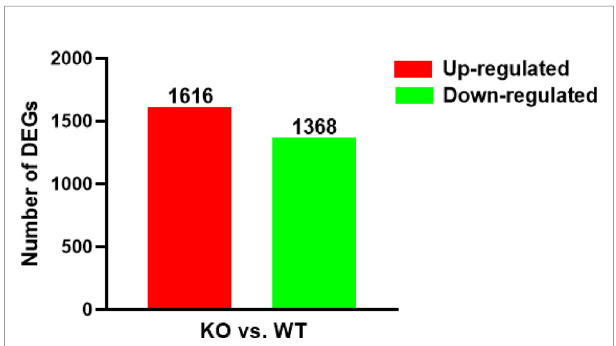
FIGURE 2 | Numbers of up-/down-regulated DEGs in two contrasts (KO vs WT). The red bars represented genes that were up-regulated in KO compared to WT, while the green bars represented genes that were down- regulated.